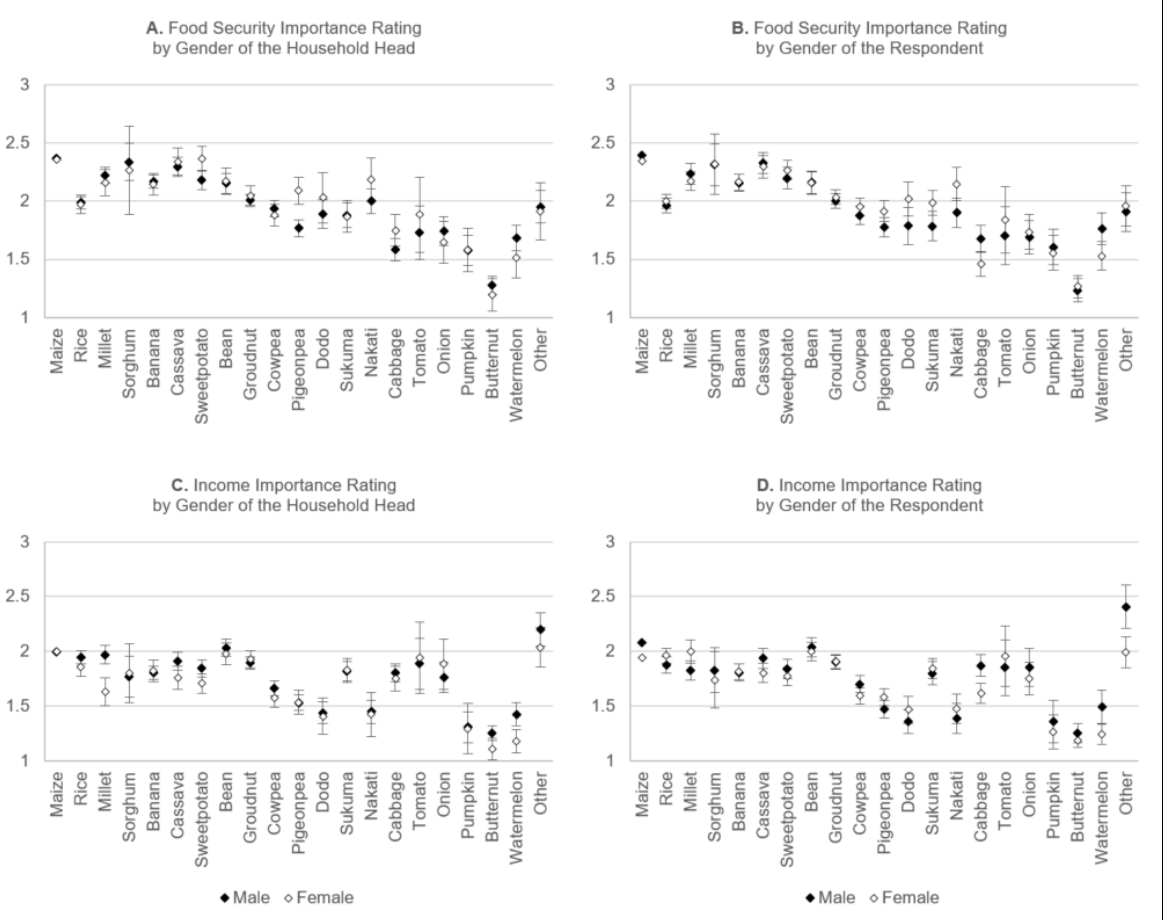
Figure 5. Importance of Different Crops for Household Food Security and Incomes, by Gender of the Household Head and by Gender of the Survey